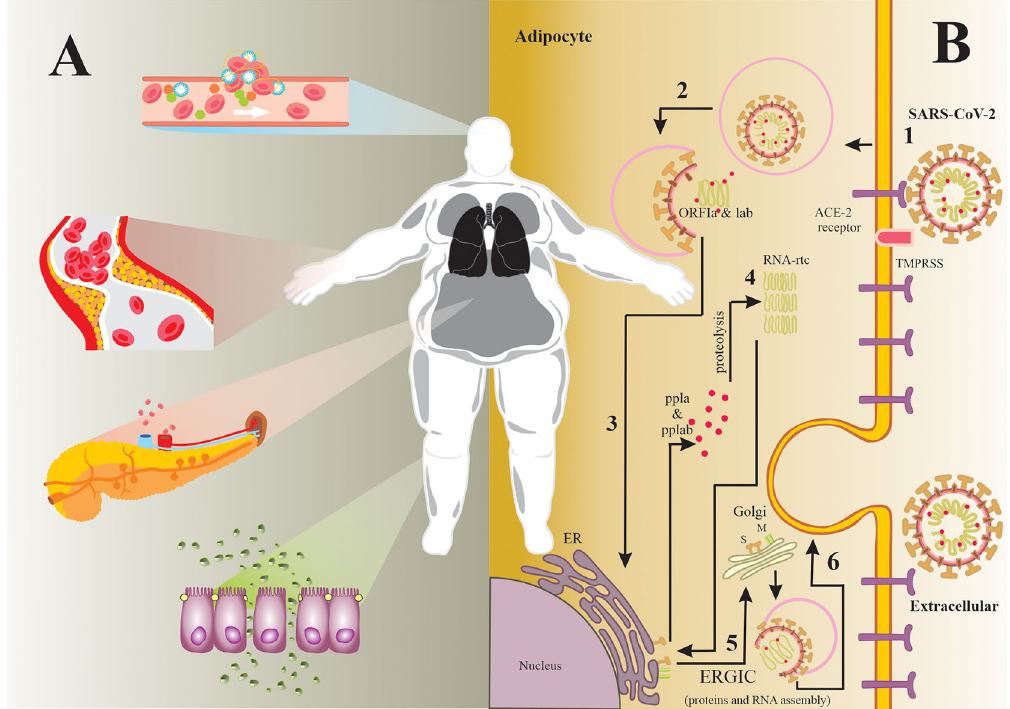
Figure 1. (A) Pathophysiological characteristics that contribute to the COVID-19 severity. It is well known that obesity is the major risk factor for other conditions such as: T2DM, hypertension and cardiovascular diseases.TheseentitiessharecommoncharacteristicsthatcontributesubstantiallytotheCOVID-19severity, For instance: endothelial dysfunction, coagulation system alterations, insulin resistance, increased pro- inflammatory mediators, among others. (B) SARS-CoV-2 infection mechanism in the adipocyte. 1) The SARS- CoV-2 S glycoprotein binds more easily to ACE-2 receptor in the adipocyte surface, since the expression levels of this receptor are higher in adipose tissue than in alveolar cells. Then, TMPRSS2 activates S glycoprotein by proteolysis to promote membrane fusion. 2) SARS-CoV-2 enters the adipocyte by endocytosis and releases its RNA genome in the cytoplasm. 3) ORF1a and ORF1ab are translated into polyproteins by the cell machin- ery. 4) These polyproteins are cleaved via proteolysis to produce structural proteins by the RNA replicase- transcriptase complex. 5) These structural proteins and viral RNA are assembled into a new virion in the ERGIC. 6) New virion is released by exocytosis. 79 – 82 Abbreviations. ACE-2: angiotensin-converting enzyme-2; ER: endoplasmic reticulum; ERGIC: endoplasmic reticulum Golgi intermediate compartment; ORF1a: open reading frames 1a; ORF1ab: open reading frames 1ab; pp1a: polyprotein 1a; pp1ab: polyprotein 1ab; RNA: Ribonucleic Acid; SARS-CoV-2: severe acute respiratory syndrome-coronavirus 2; T2DM: type 2 diabetes mellitus; TMPRSS2: Trans- membrane protease, serine